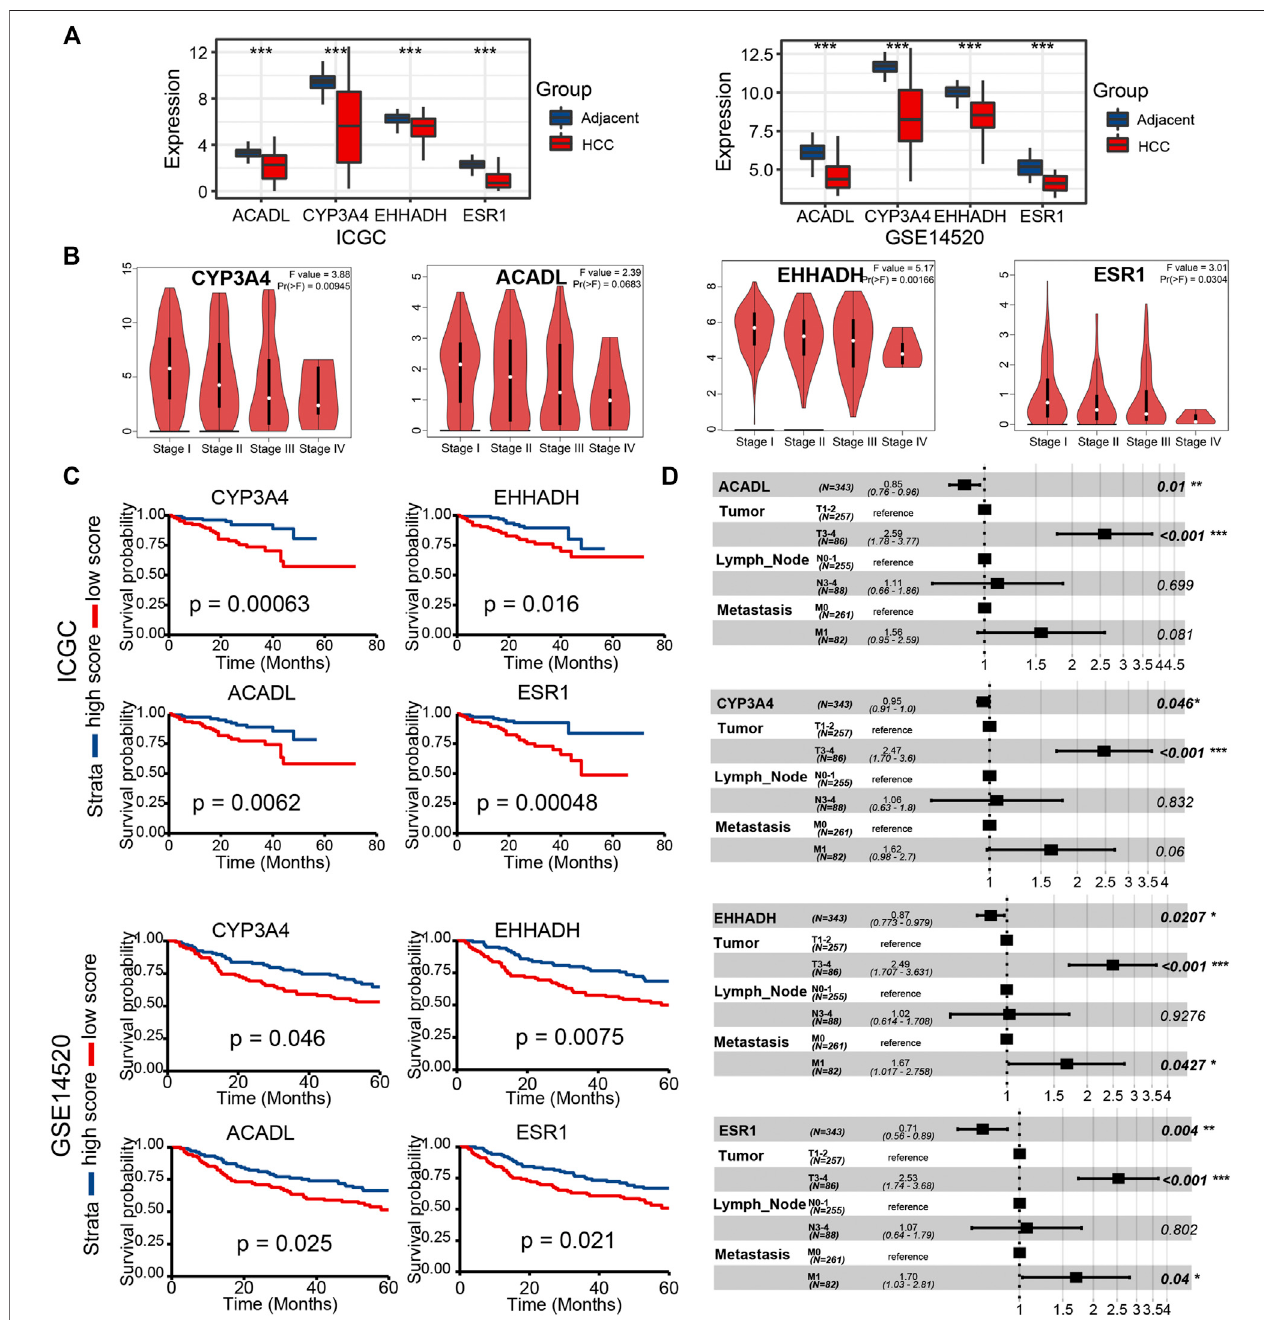
FIGURE 9 | Validation of key LCGs in expression level and prognostic signi fi cation (A) The expression level of key genes in LIHC tissues and normal tissues based on ICGC and GSE14520. (B) Differentiated expression of key genes in different LIHC stages based on the GEPIA database. (C) KM plots of key LCGs based on ICGC and GSE14520. (D) Multivariate Cox regression of key LCGs. * p < 0.05, ** p < 0.01, *** p < 0.001, **** p < 0.0001.